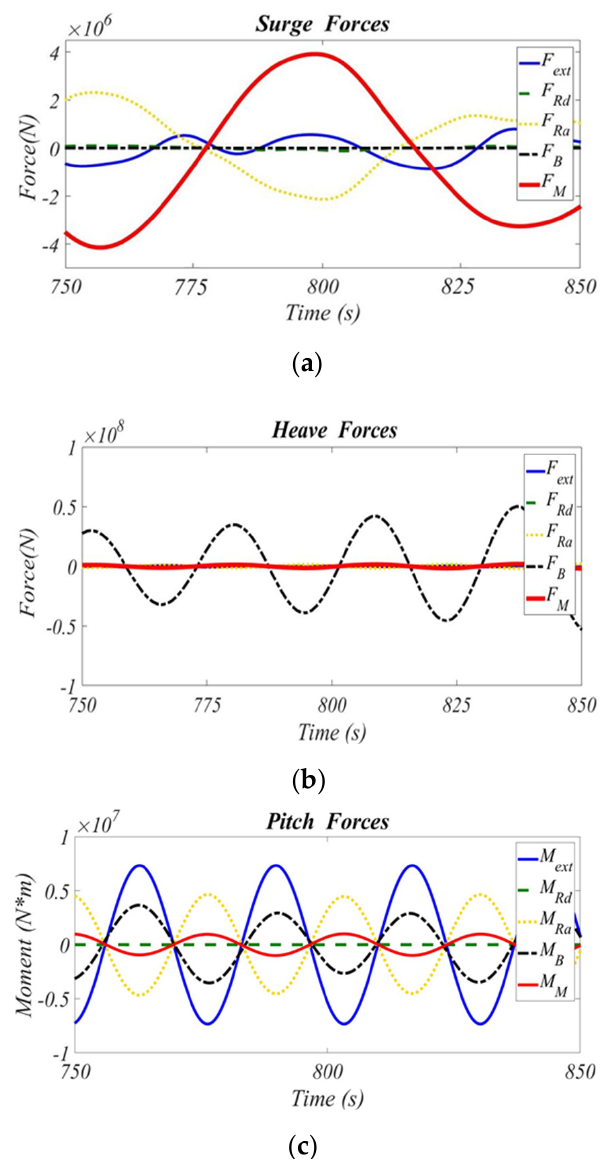
Figure 18. Time histories of wave-load components at ( a ) the surge natural frequency ( f p = 0.014 Hz), ( b ) the heave natural frequency ( f p = 0.052 Hz), and ( c ) the pitch natural frequency ( f p = 0.054 Hz) for the UMaine-Hywind spar.